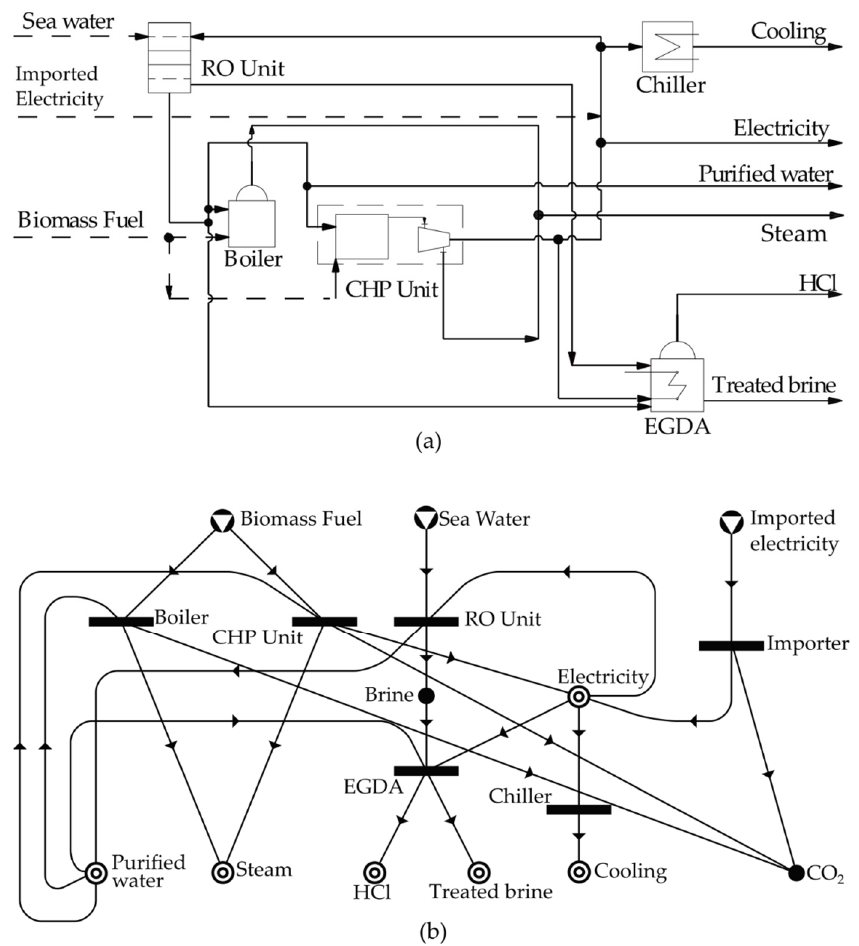
Figure 3. Problem structure for synthesis of polygeneration system in conventional representation ( a ) and P-graph representation ( b ). and P-graph representation ( b